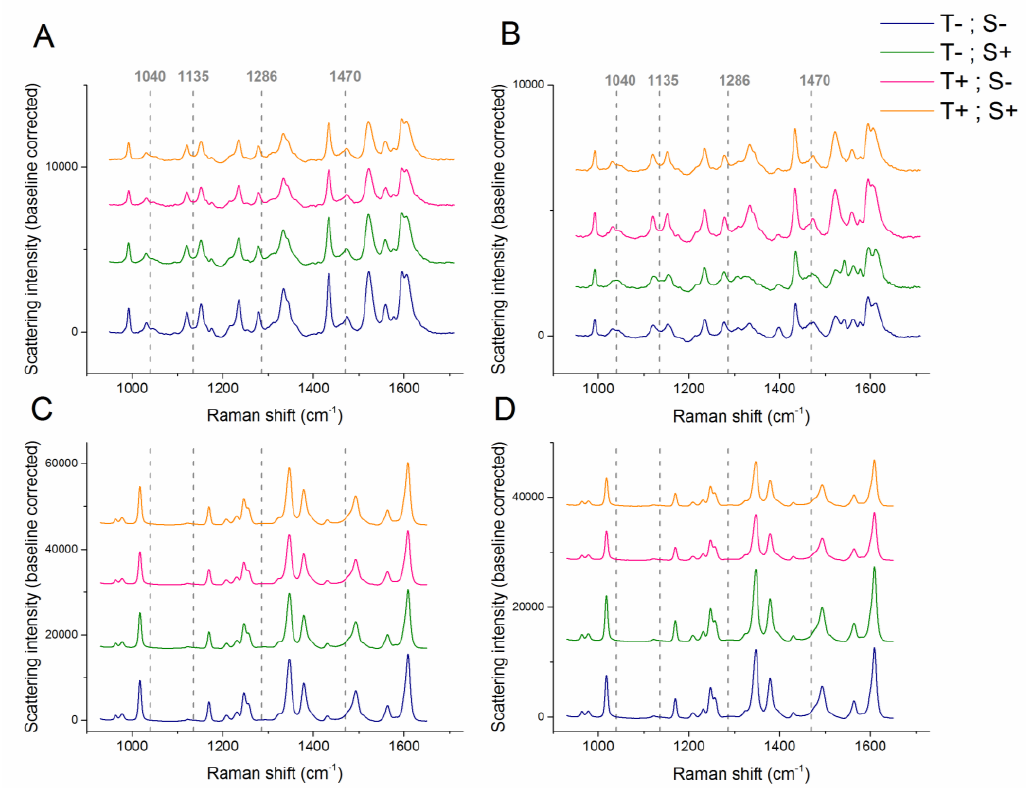
Figure 1. Raman spectra of ( A ) piroxicam anhydrate-polyethylene oxide (PRXAH-PEO), ( B ) piroxicam monohydrate-polyethylene oxide (PRXMH-PEO), ( C ) nitrofurantoin anhydrate-polyethylene oxide (NFAH-PEO) and ( D ) nitrofurantoin monohydrate-polyethylene oxide (NFMH-PEO) melts after 10 min of recirculation in the extruder. T − : 70 ◦ C, T + : 90 ◦ C, S − : 25 rpm and S + : 50 rpm. Dashed lines indicate the significant Raman shifts related to PEO.